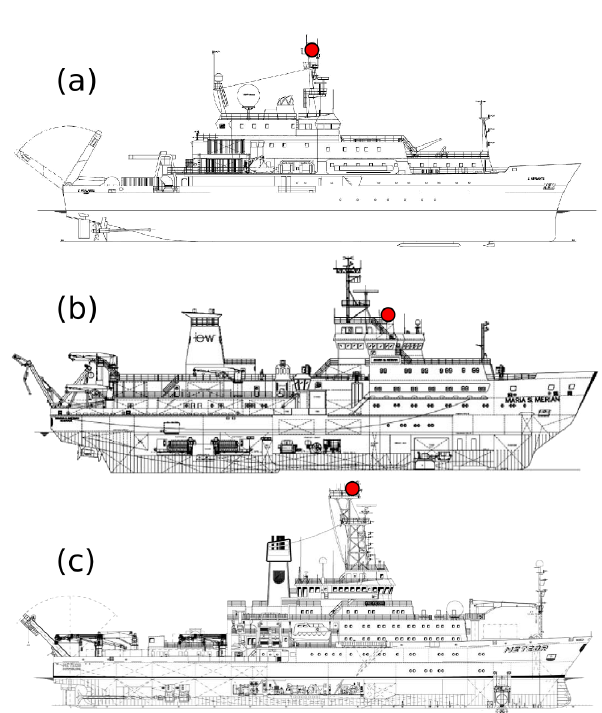
Figure 1. Schematic diagram of the location of the GNSS antennas used (red circles) on R/V Atalante (a) , R/V Maria S. Merian (b) and R/V Meteor (c) during the EUREC 4 A campaign. Schematic diagrams are courtesy of Génavir and Briese